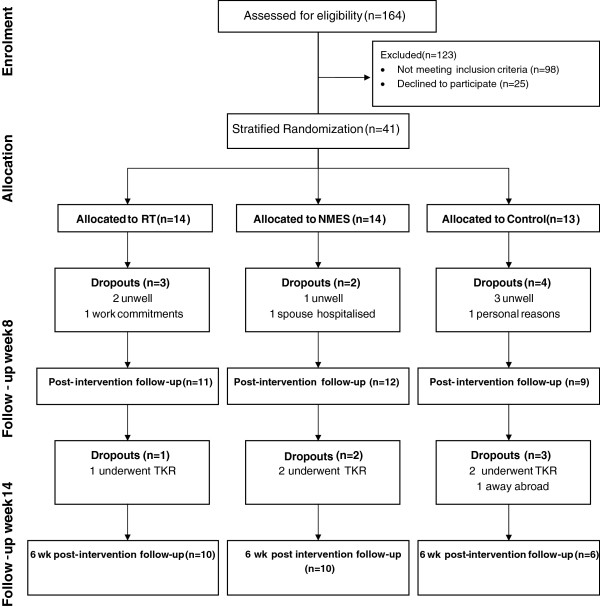
Participant flow.